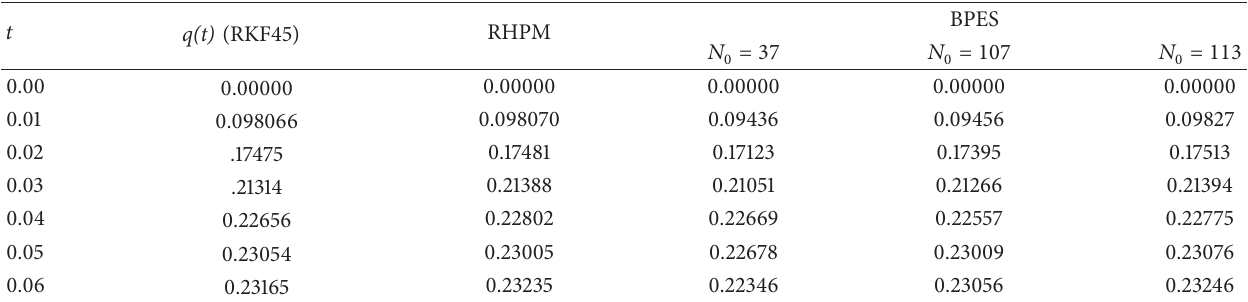
Table 1: Numerical comparison of proposed solutions and RKF45 solution of